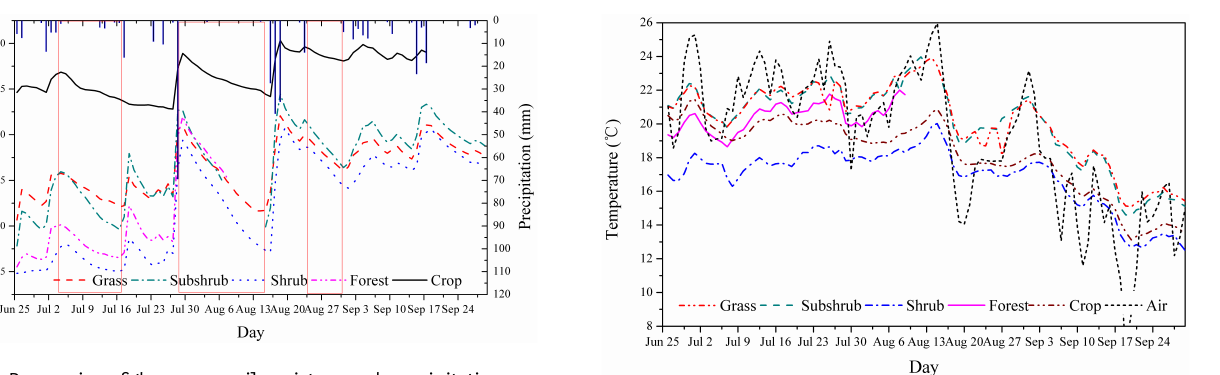
Fig. 2. Dynamics of the mean soil moisture and precipitation pro- files and the three selected typical decreasing moisture periods. Fig. 3. Dynamics of the mean soil and air temperature during the study